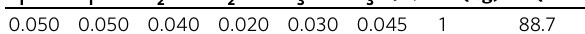
Table 1 Physical parameters for the system with three . max